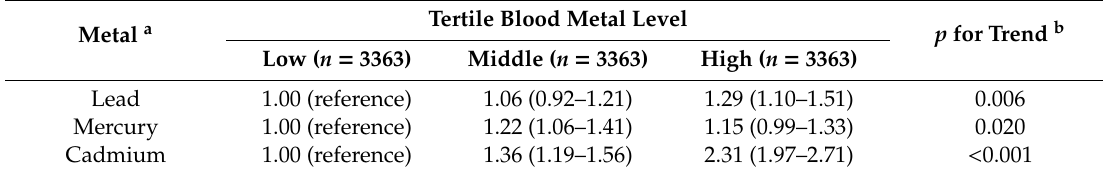
Table 2. Adjusted odds ratios and 95% confidence intervals of hypercholesterolemia by blood metal level.